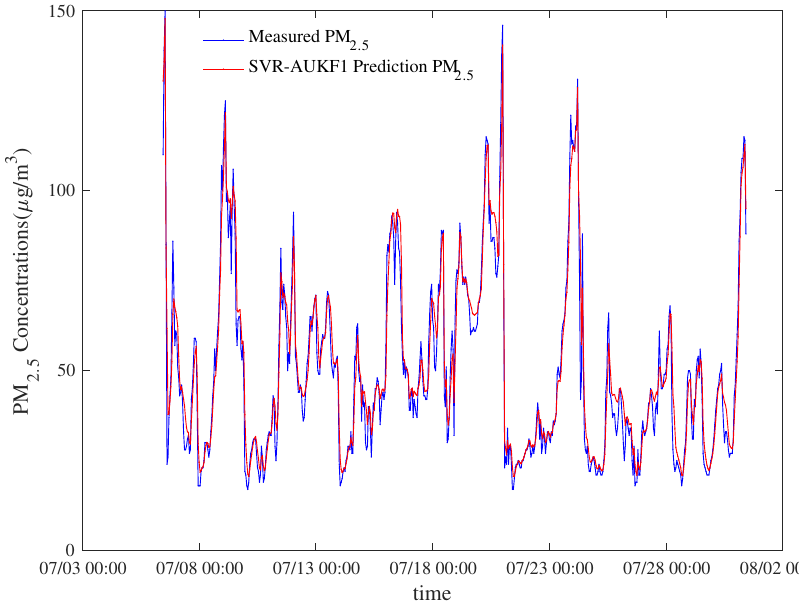
Figure 7. The PM 2.5 concentration prediction of SVR-AUKF1. The prediction residuals of SVR-AUKF1 are shown in Figure 8.